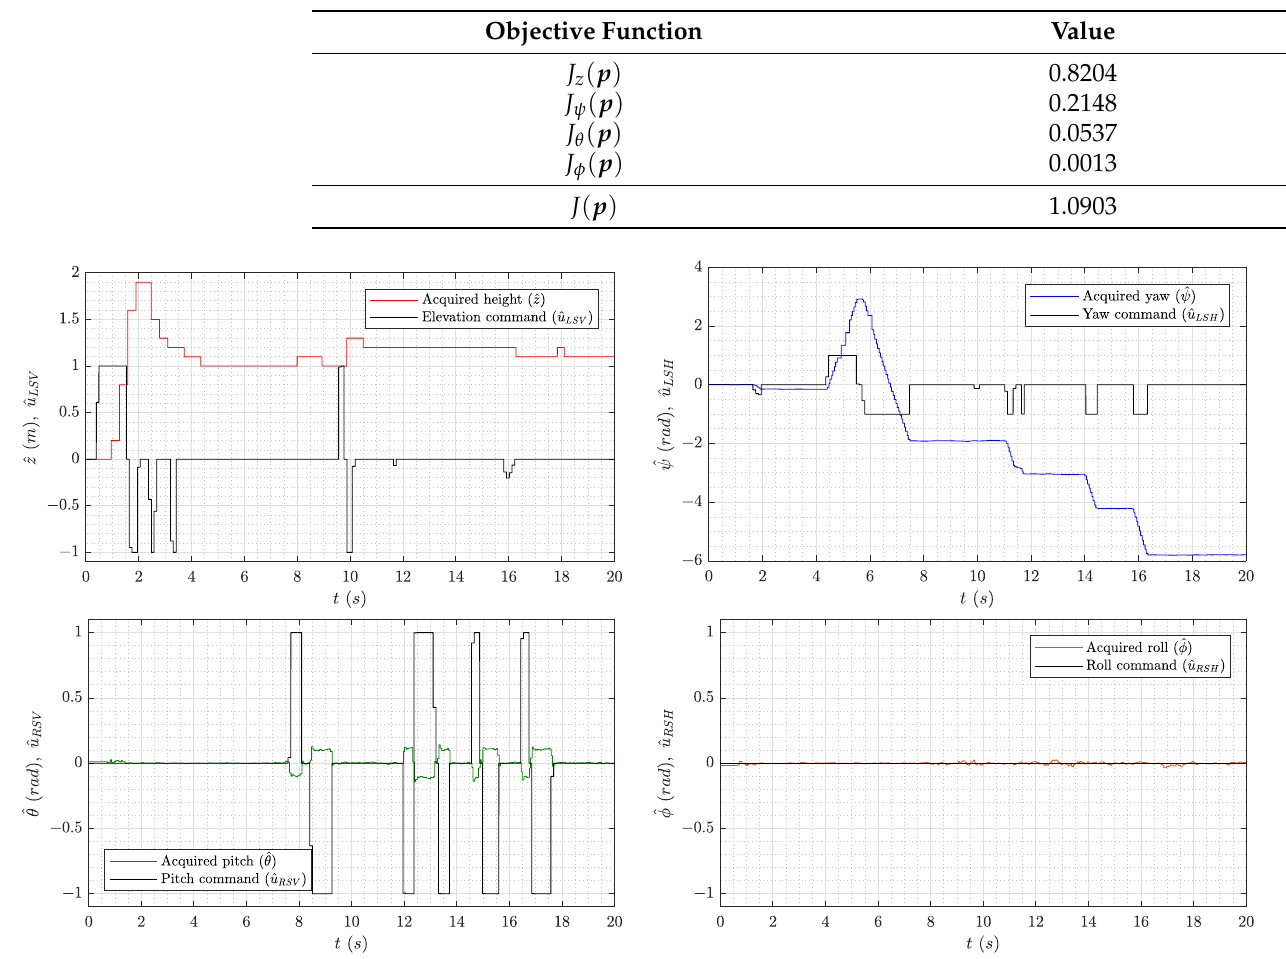
Figure 9. The data acquired from the DJI Ryze Tello.